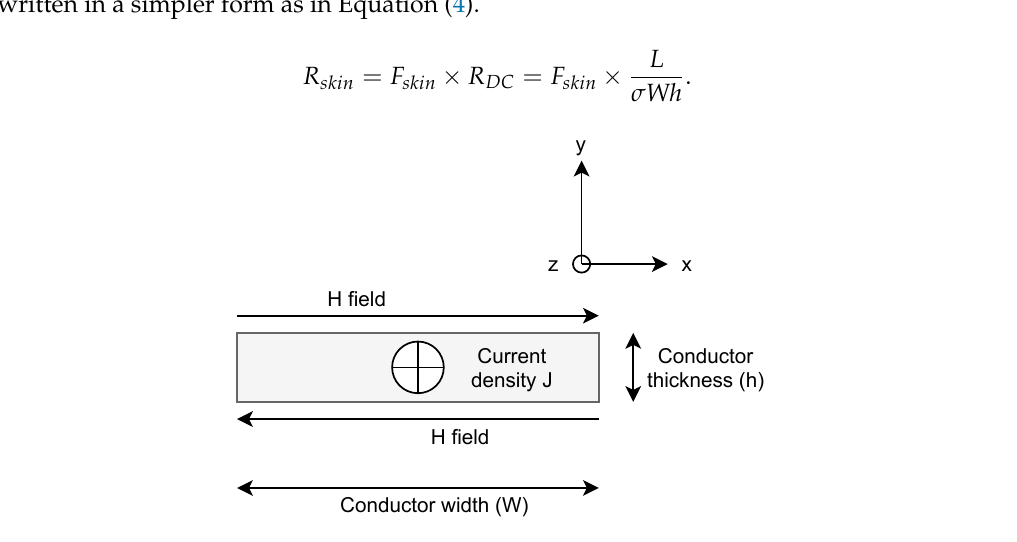
Figure 2. A rectangular conductor with its magnetic field.